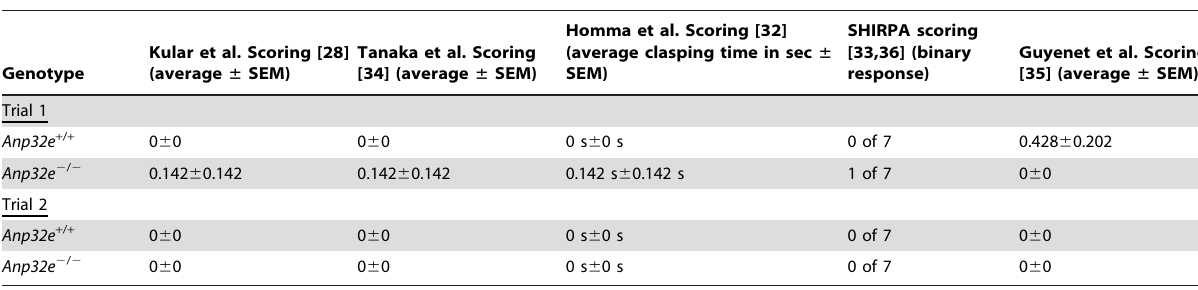
Table 1. Limb clasping assay quantification for targeted ANP32E-deficiency.